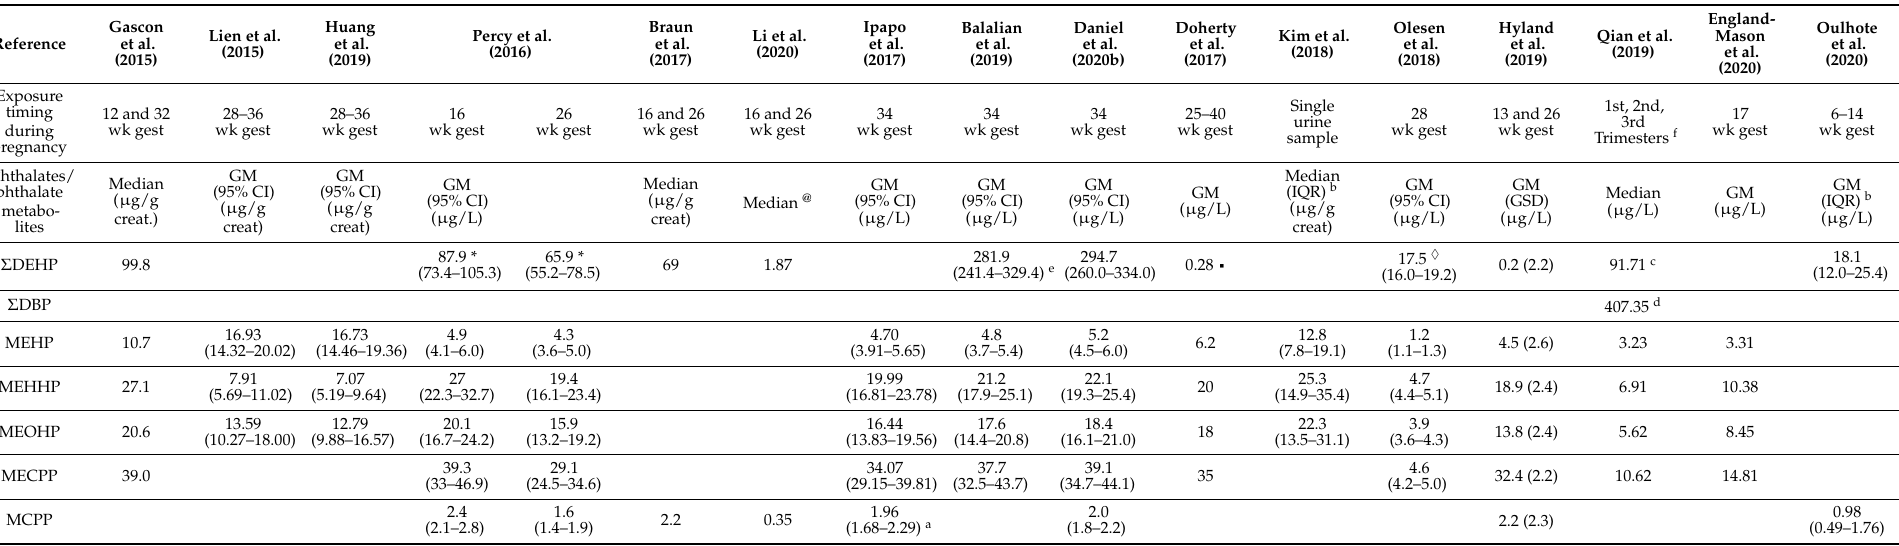
Table 2. Concentrations of the phthalate metabolite in maternal urine ( µ g/L, µ g/g